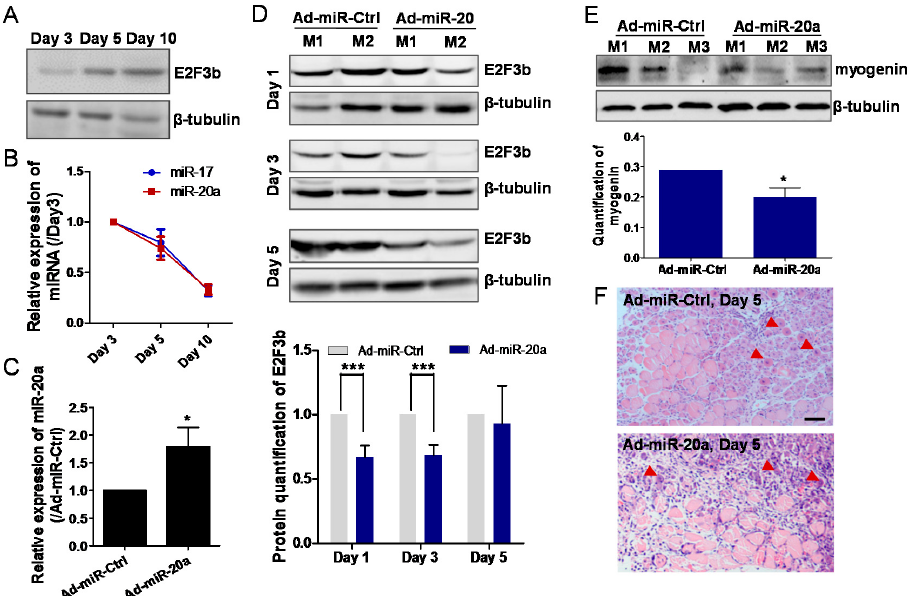
Figure 3. miR-20a regulates E2F3b expression in vivo . ( A ) Western blotting showing that E2F3b protein was upregulated during muscle regeneration after cardiotoxin (CTX)-injury; ( B ) Quantitative RT-PCR was performed to analyse the expression of miR-17 and miR-20a on 3, 5, and 10 days post CTX-injury. The data are presented as the means ± SD. Data are representative of three independent samples; ( C ) Relative expression of miR-20a in Ad-miR-20a mice compared with Ad-miR-NC mice